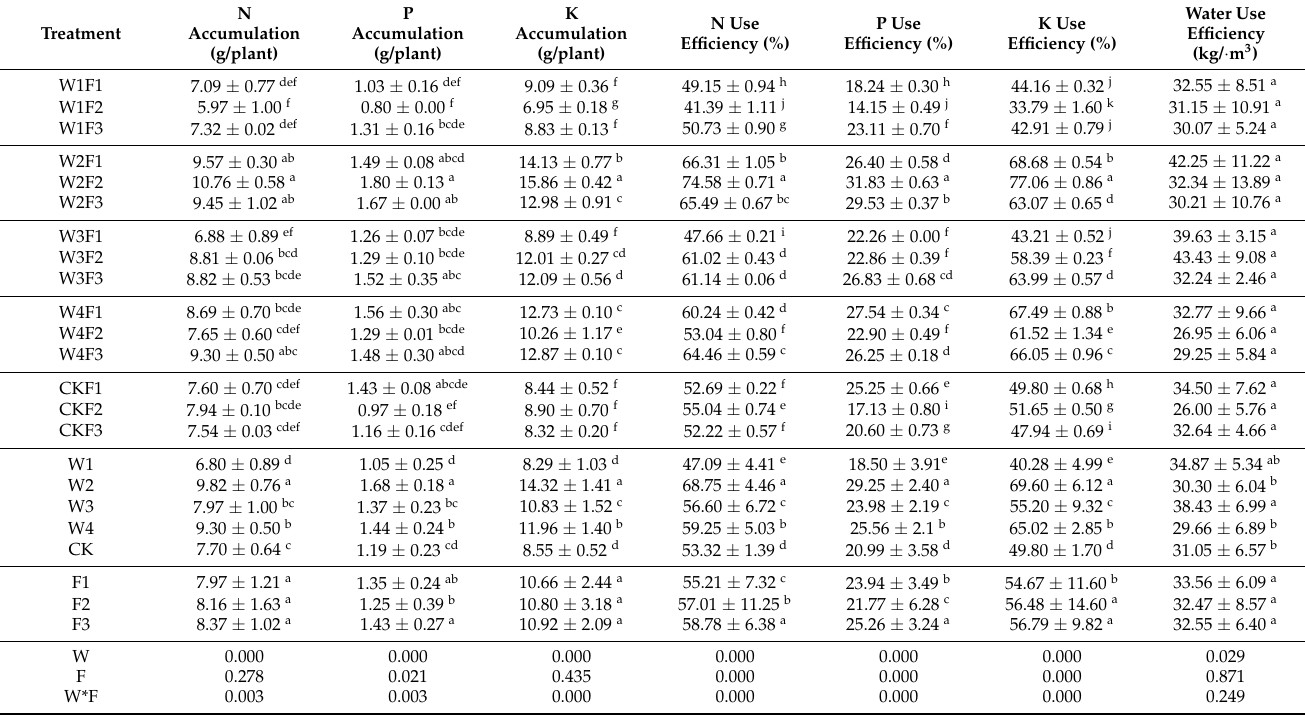
Table A1. Effects of different treatments on IWUE and NUE of